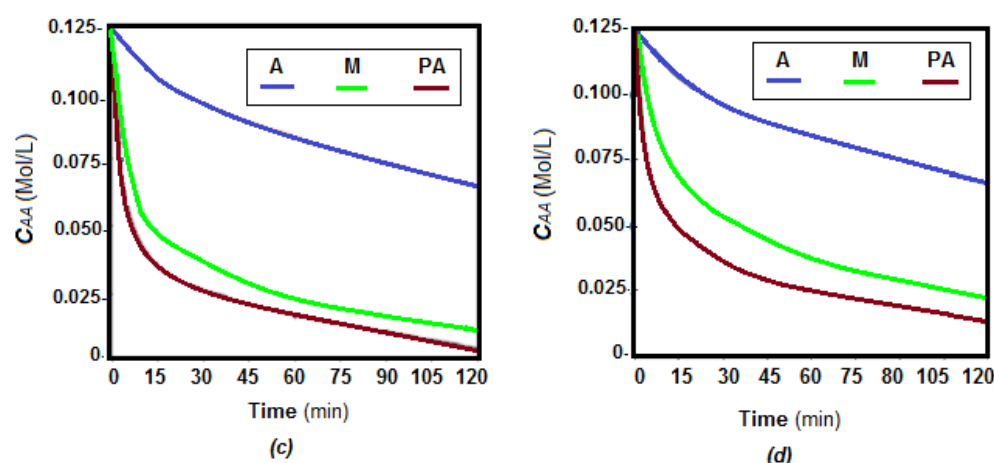
Figure 15. Variation of source phase amino acid concentration depending on the operating time at pH SP = 12 and pH RP = 7: ( a ) CA–PPM; ( b ) HEC–PPM; ( c ) MHEC–PPM; ( d ) NaCMC–PPM. A = alanine (blue); M = methionine (green) and PA = phenylalanine (brown).